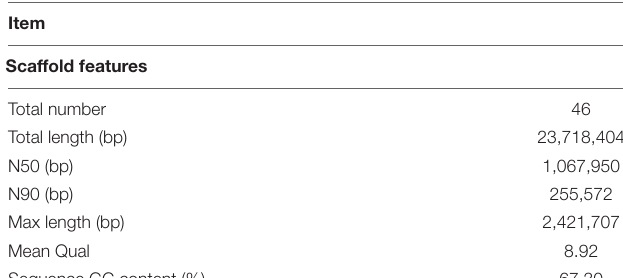
TABLE 2 | Genome assembly results statistics.